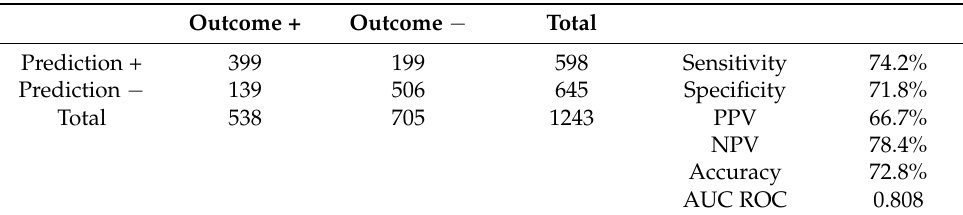
Table 3. Excellent clinical outcome AI